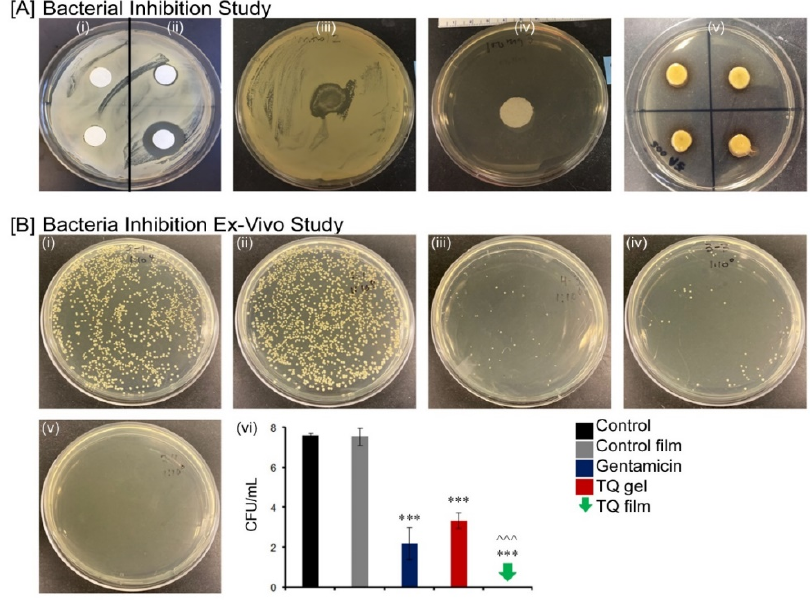
Figure 5. Bacterial inhibition study. ( A ) Inhibition of bacterial growth on agar plate by Control negative (i); Gentamicin positive control 50 µg/mL (ii) right upper and 500 µg/mL (ii) right lower; Control film (iii); TQ hydrogel (iv) and TQ film (v) against S. aureus ; ( B ) Ex vivo antibacterial activity by Control (i); Control film (ii); Gentamicin sulfate USP, 0.1% marketed cream (iii); TQ hydrogel (iv); TQ film (v) and Log of bacterial reduction with di ff erent treatment groups (vi). Data represent of four replicates. *** p ≤ 0.001 and ˆˆˆ p ≤